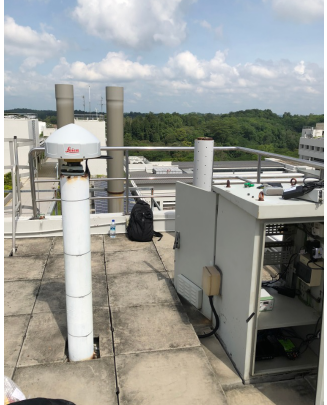
Figure 1. Photo of the IGS station (station ID: NTUS) at Nanyang Technological University, Singapore. Photo adapted from